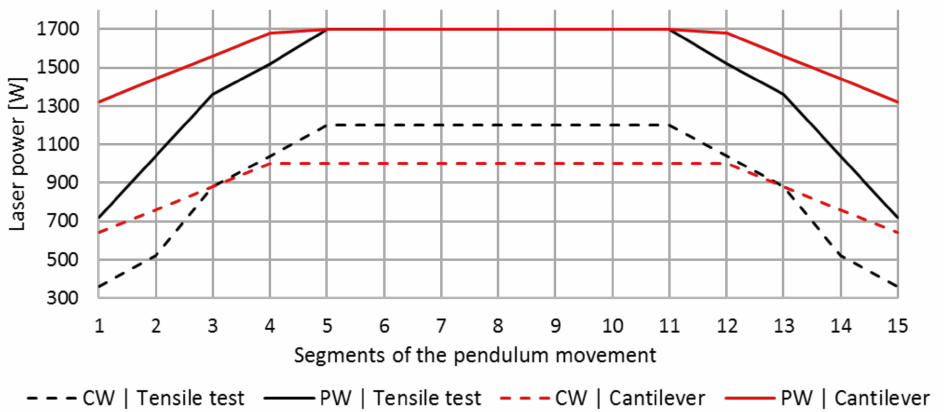
Figure 6. Used laser power curves over the pendulum movement, depending on the laser operation mode and specimen